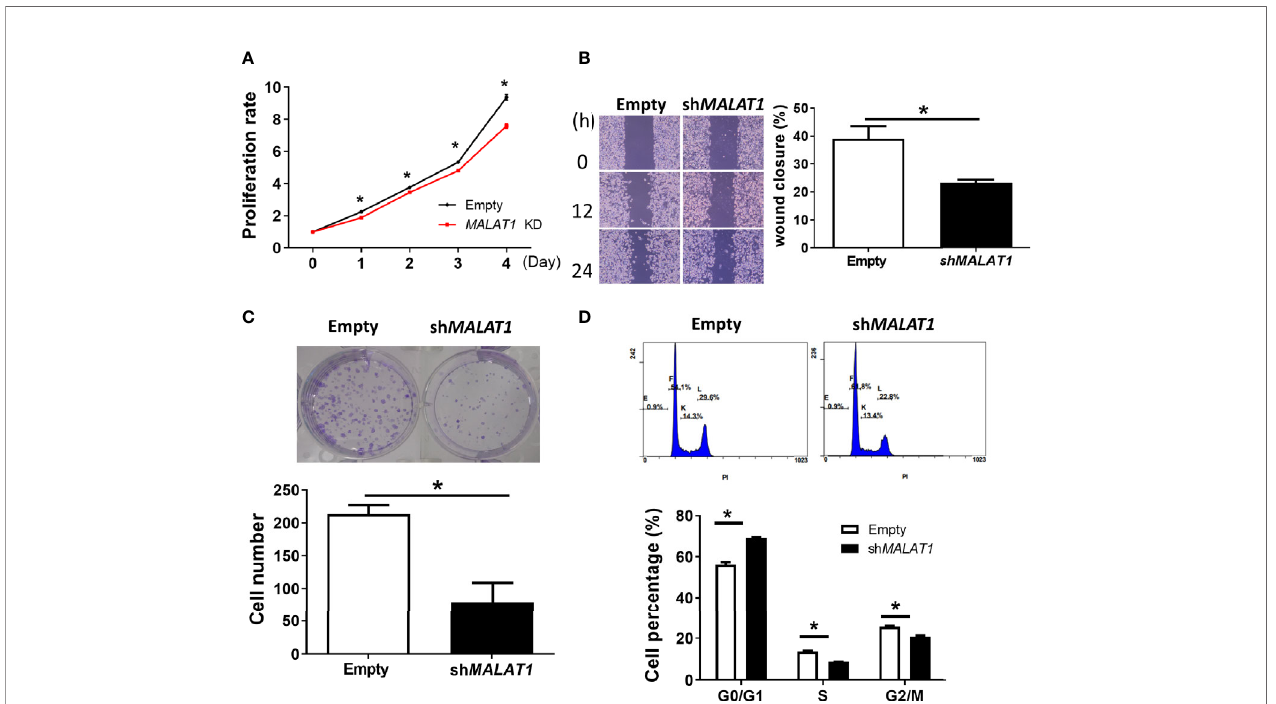
FIGURE 6 | Knockdown of MALAT1 decreases proliferation and metastasis in MDA-MB-231 cells. (A) Measurement of cell proliferation using MTT assays. Cell growth was measured in MDA-MB-231 cells transduced with lentivirus which expresses shRNA against MALAT1 . The proliferation rate was normalized to day zero. (B) Wound healing assay. Left: Representative pictures of wound healing assays. After 24 h of transduction, wound healing was photographed at 0, 12, and 24 h. Right: Migration ability was quanti fi ed as reduction in wound size at 24 h. (C) Colony formation assay. Top: Representative pictures of colony formation assays. Colonies with cell numbers more than fi fty were counted. Bottom: Quanti fi cation of results. (D) Cell cycle distribution by fl ow cytometry. Top: Representative diagrams of fl ow cytometry. After 48 h of transfection, cells were harvested and stained with PI. Bottom: Quanti fi cation of results as the percentage of cells in each phase of the cell cycle. All data shown are the means ± SDs (n = 3). * P <